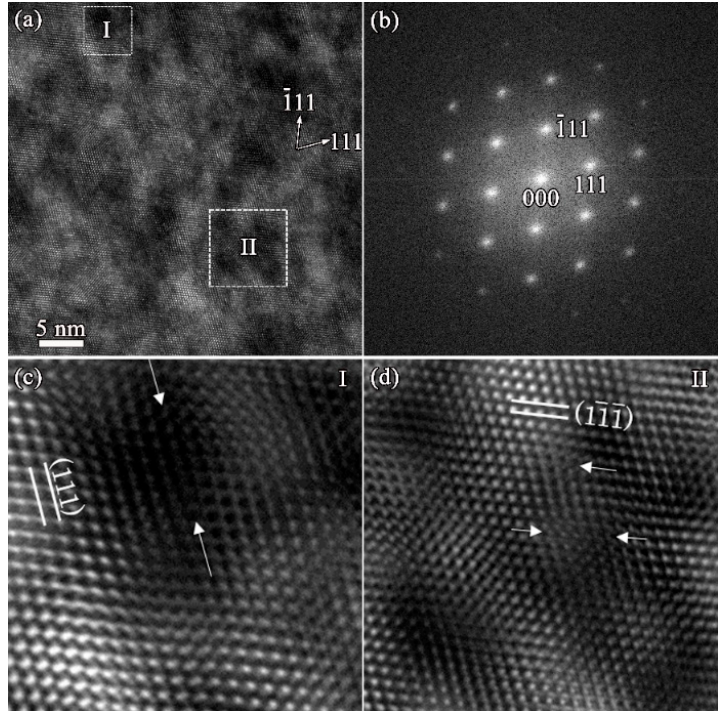
Figure 6. ( a ) High-resolution (HR)-TEM images of the damaged area interior obtained from the zone axis [011] in irradiated ZrC; ( b )Fourier transformation of ( a ); ( c ) Fourier-filtered (111) diffraction lattice images; ( d ) Fourier-filtered (11 — 1 — ) diffraction lattice images.